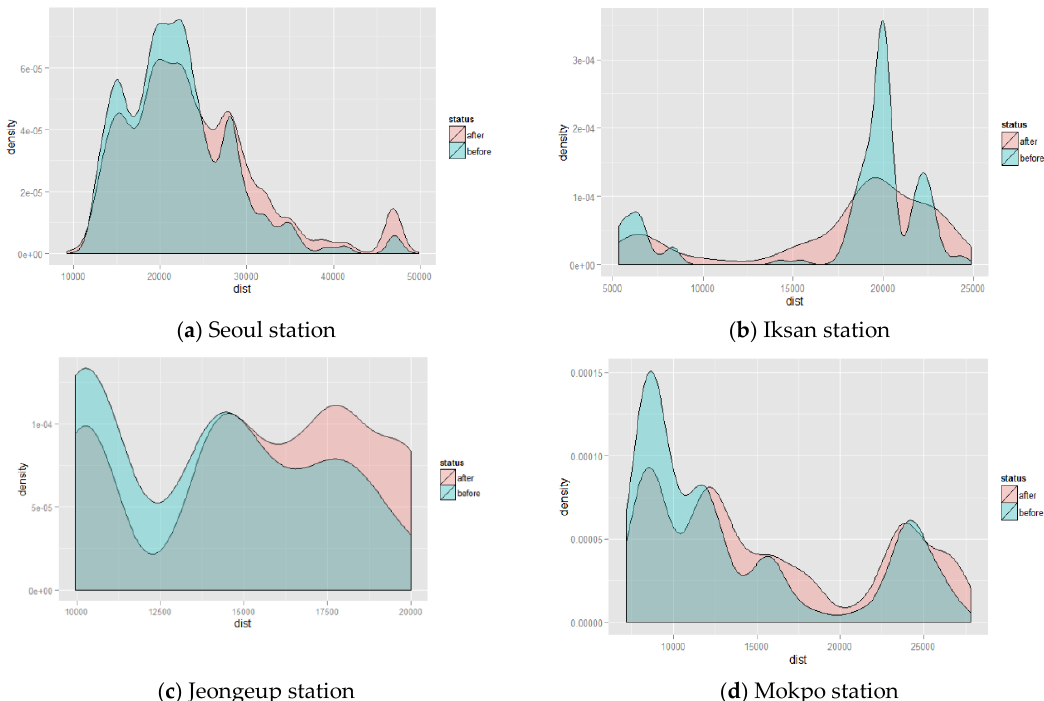
Figure 4. Comparison of density of access distance before and after the opening of the HSR.